Question: What style of plot is this figure drawn as?
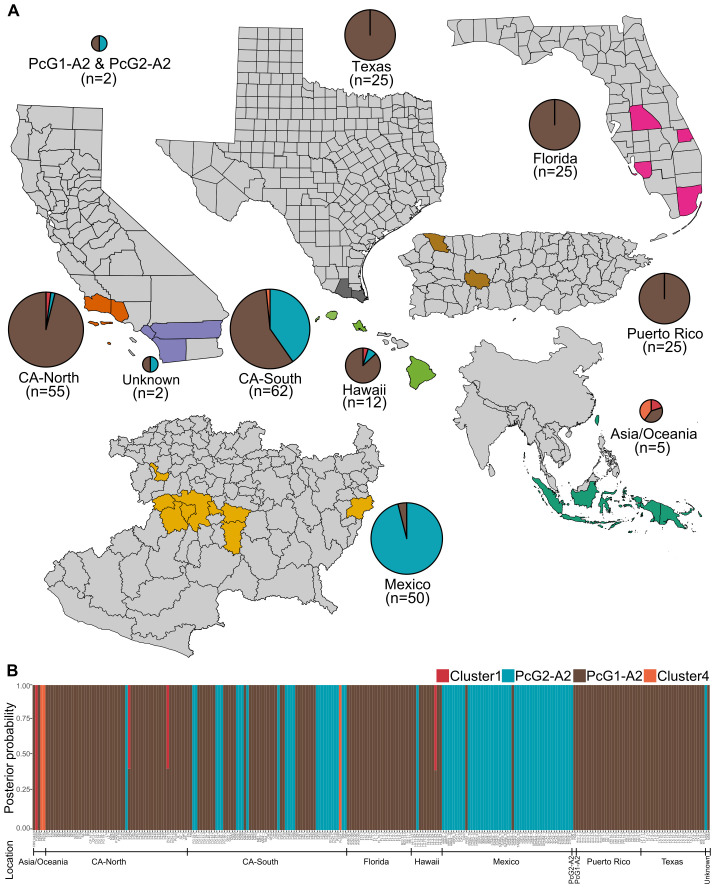
Answer: pie